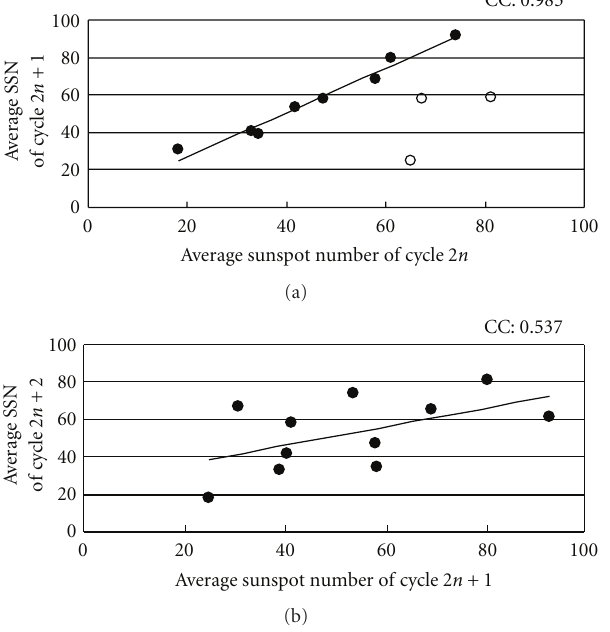
Figure 7: (a) Average sunspot number of odd-numbered solar cycles versus that of the preceding even-numbered cycles showing correlation between average SSN of solar cycle 2 n and that of solar cycle (2 n + 1), where n represents an integer. (b) is the same as (a) but showing average sunspot number of even-numbered solar cycles (2 n + 2) versus that of the preceding odd-numbered cycles (2 n + 1).